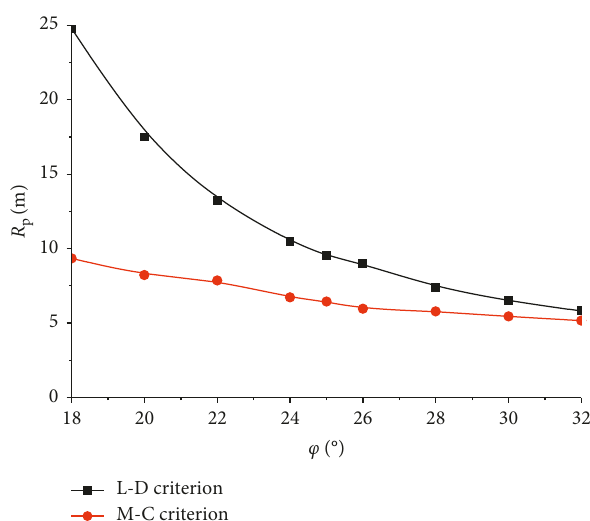
Figure 3: Relation curves between internal friction angle and plastic zone radius.